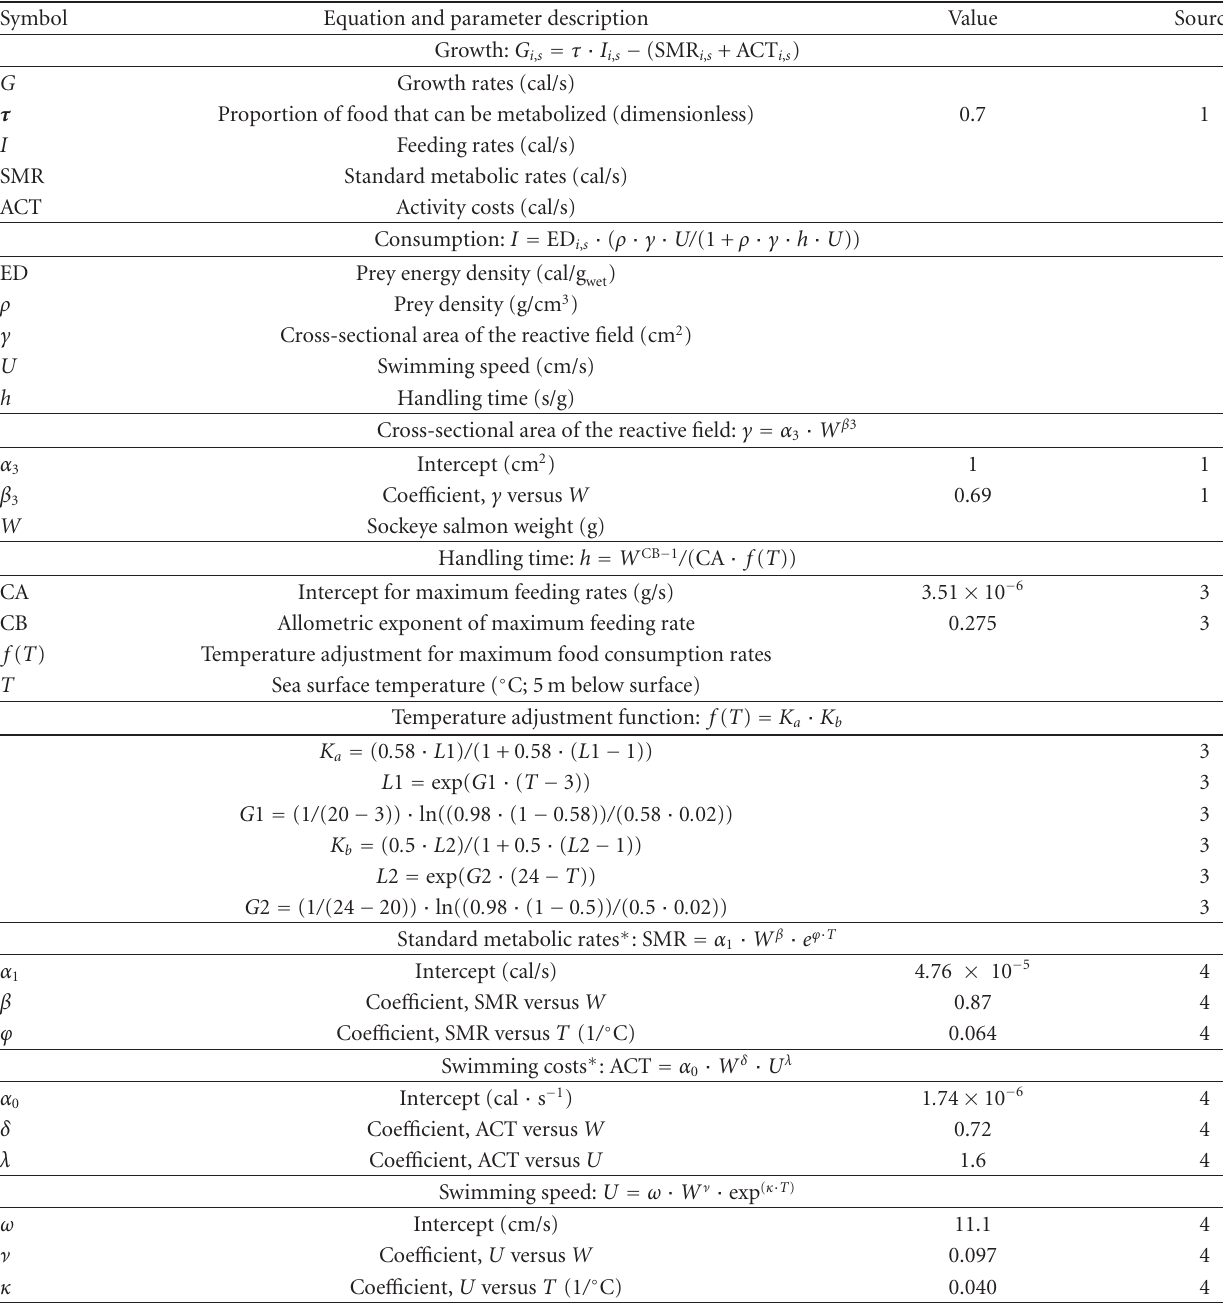
Table 1: Equations and parameter description of the sockeye salmon bioenergetics model. Note that subscripts i and s represent year ( i = 2000 to 2006) and station, and overbars denote mean quantities within the definitions of i